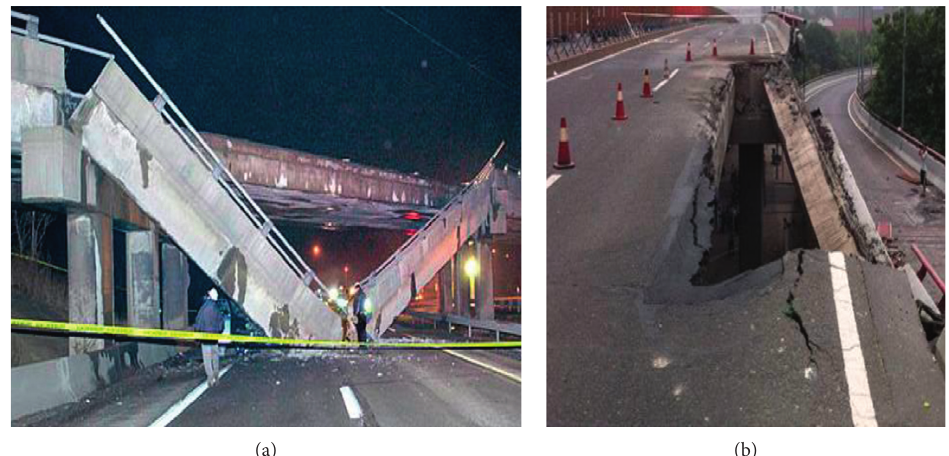
Figure 1: The collapse of exterior beams of adjacent concrete box beam bridges. (a) Lake View Drive Bridge, USA, 2005. (b) Third Hangzhou Qiantang Bridge, China,